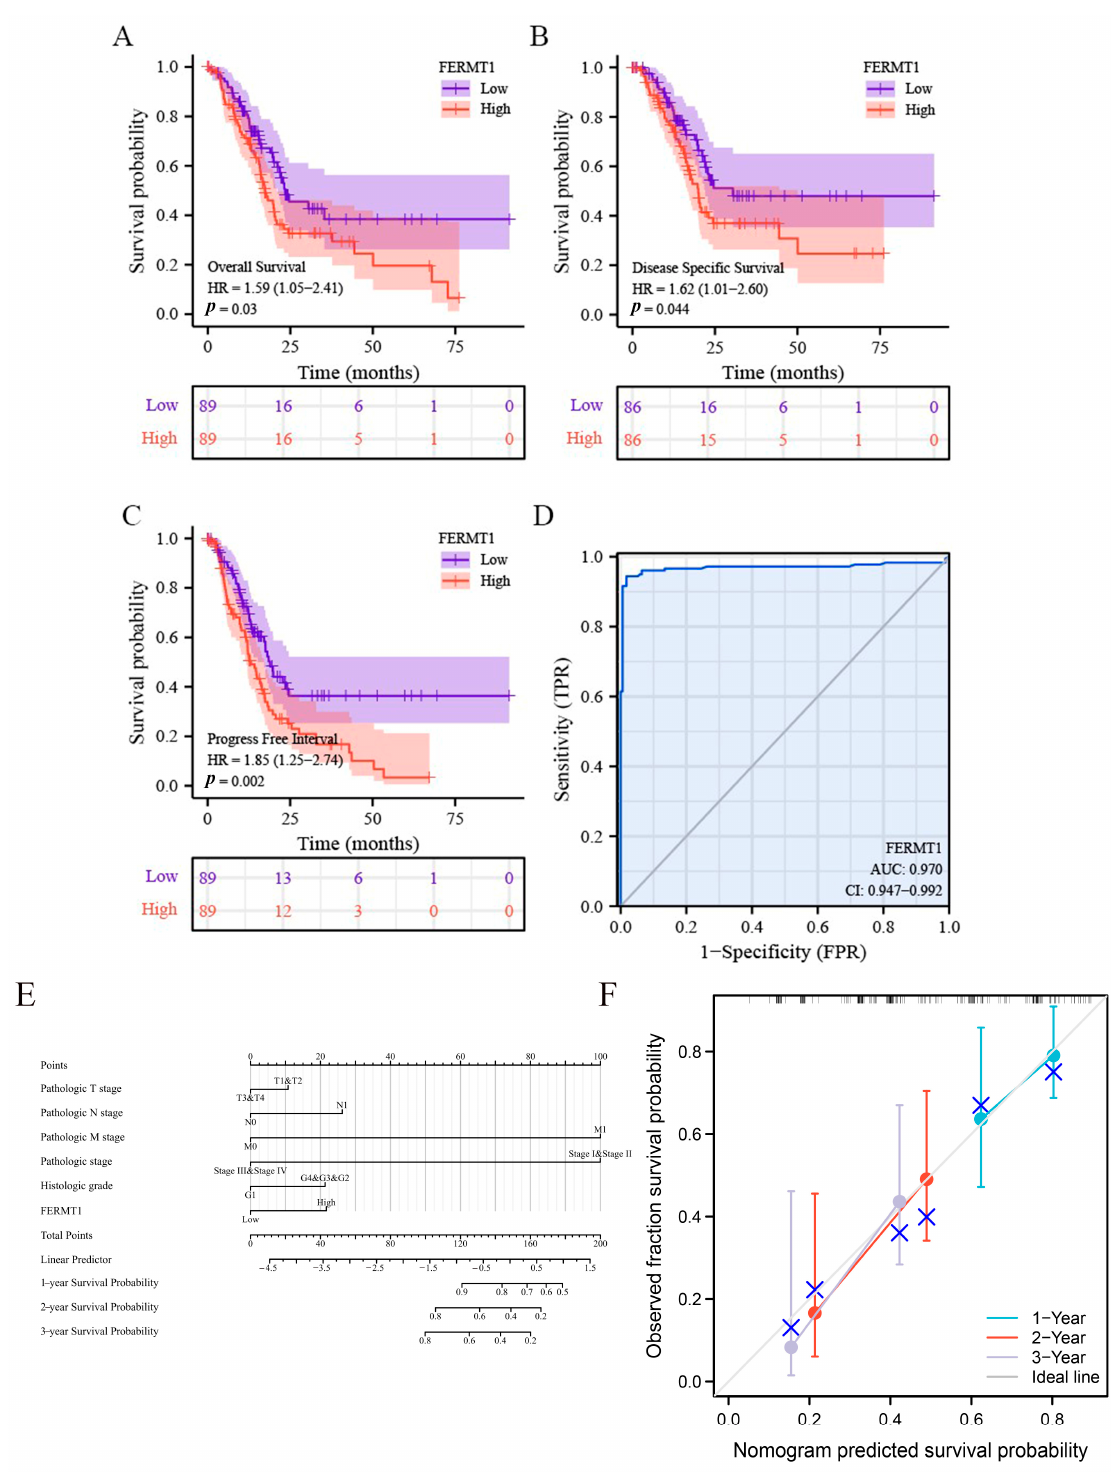
Figure 3. The prognostic value of FERMT1 expression in PAAD patients. ( A ) OS, ( B ) DSS and ( C ) PFI analysis in the Kaplan–Meier Plotter database based on TCGA data. ( D ) The ROC curve was performed to assess the diagnostic efficiency of FERMT1 in PAAD. ( E ) A nomogram and ( F ) calibration curves for estimating 1-, 2-, and 3-year OS of PAAD patients.